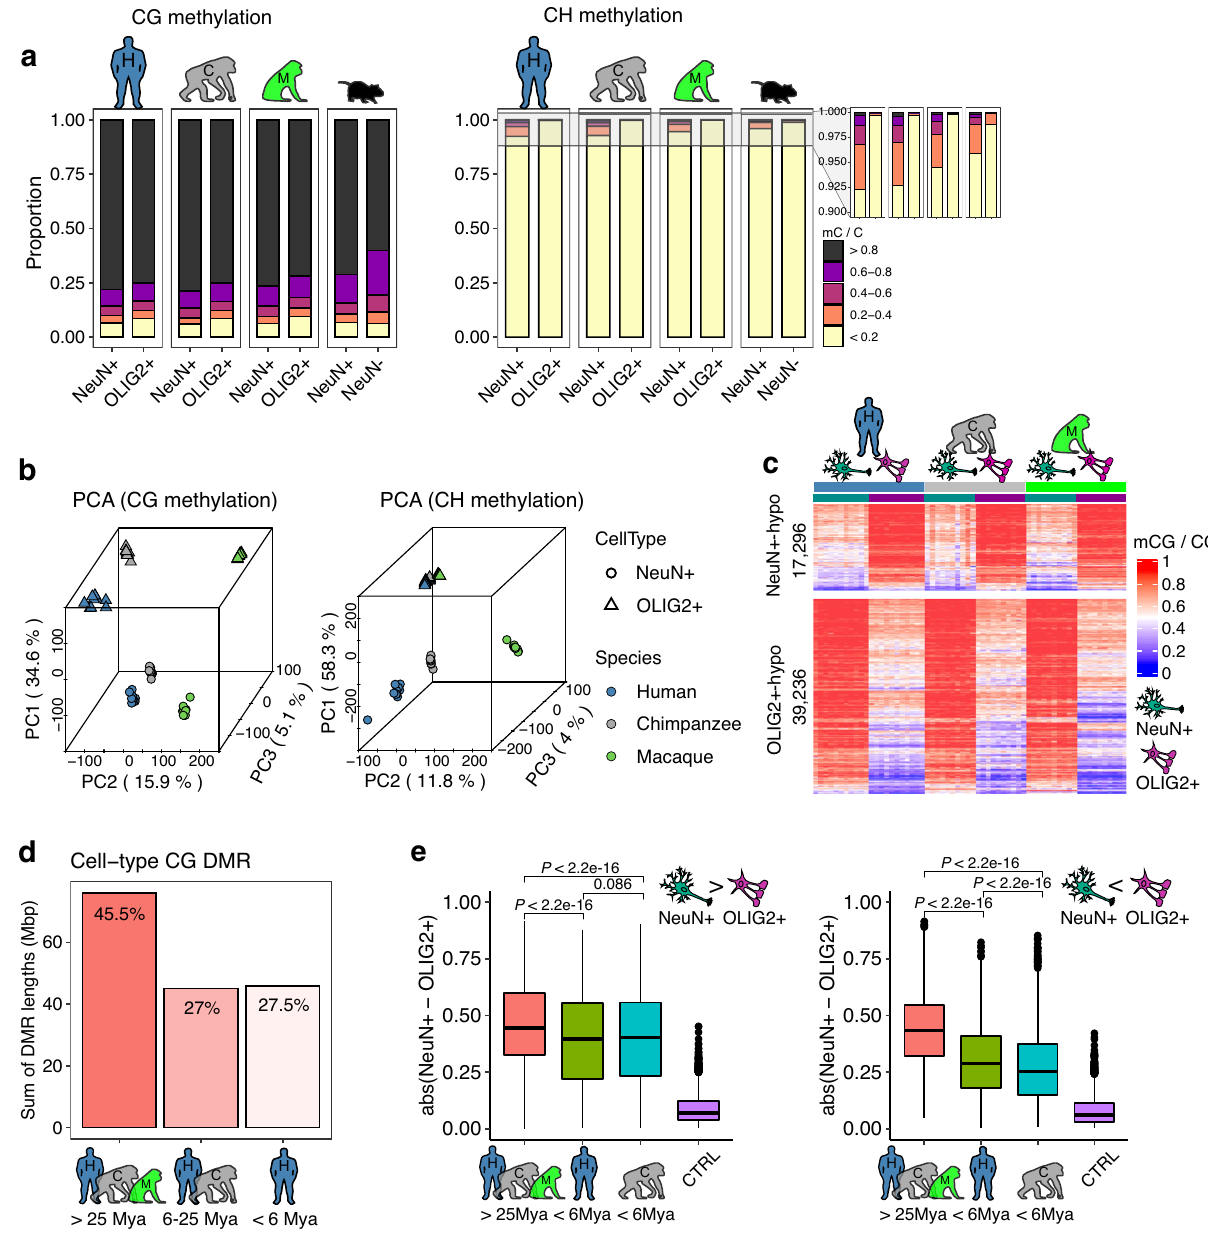
Fig. 1 CG and CH methylation in neurons (NeuN + cells) and oligodendrocytes (OLIG2 + cells) in human and non-human primate prefrontal cortex. a The proportions of methylated CG and CH sites. Human and non-human primate neurons and oligodendrocytes are highly CG methylated. Human and non-human primate neurons show low levels of CH methylation and oligodendrocytes show even lower levels. CH methylation is highest in human neurons, followed by chimpanzees, rhesus macaques, and mice. b Principal component analysis of methylated cytosines in two contexts (CG and CH). The top two principal components (PCs), PC1 and PC2, distinguish cell-type and species, respectively. c CG methylation levels in neurons (left columns for each species) and oligodendrocytes (right columns for each species). A greater number of DMRs are hypermethylated in neurons (red, in the left columns) compared to oligodendrocytes (right columns). d Approximately half (45.5%) of CG DMRs differentially methylated between NeuN + and OLIG2 + cells are conserved in all three species, with 27% conserved between humans and chimpanzees, and 27.5% speci fi c to the human. e The absolute methylation difference of NeuN + and OLIG2 + cells is highest for DMRs conserved in all three species (39,202 and 17,284 DMRs hypermethylated in neurons and oligodendrocytes, respectively) compared to those speci fi c to humans (3103 and 5361 DMRs hypermethylated in neurons and oligodendrocytes, respectively) or chimpanzees (4370 and 2989 DMRs hypermethylated in neurons and oligodendrocytes, respectively). DNA methylation differences between NeuN + and OLIG2 + cells calculated from genomic regions serving as statistical control (CTRL), with a matched number of CG and G + C nucleotide contents, are also displayed. Statistical signi fi cance was computed using two-sided Mann – Whitney U -test. Box represents a range from the fi rst quartile to the third quartile. The line in the box indicates the median value. The minima and maxima are within 1.5 times the distance between the fi rst and third quartiles from box. Source data are provided as a Source Data fi le. Cell-type images were color modi fi ed from the original image, which was